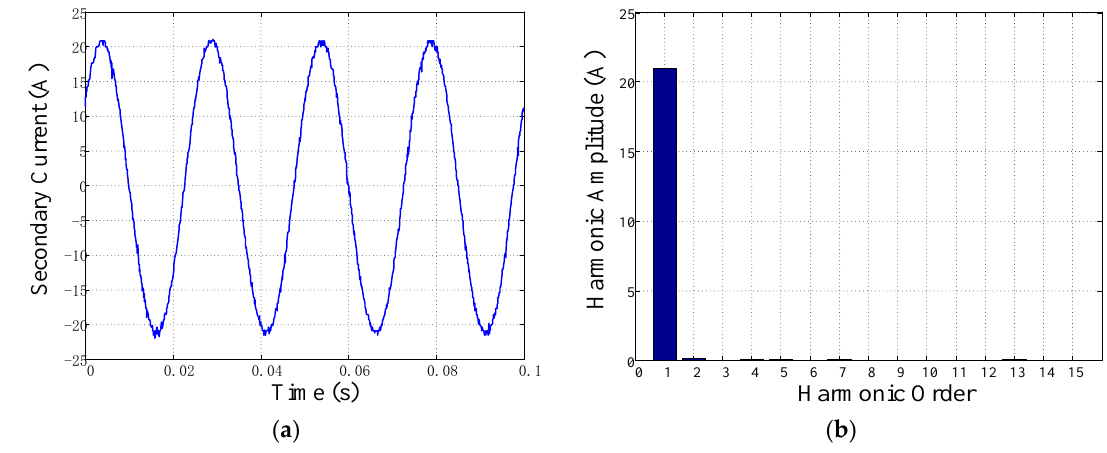
Figure 11. Winding currents of the DSFM motor at 200 rpm: ( a ) secondary winding current; and ( b ) the harmonic content of the current.